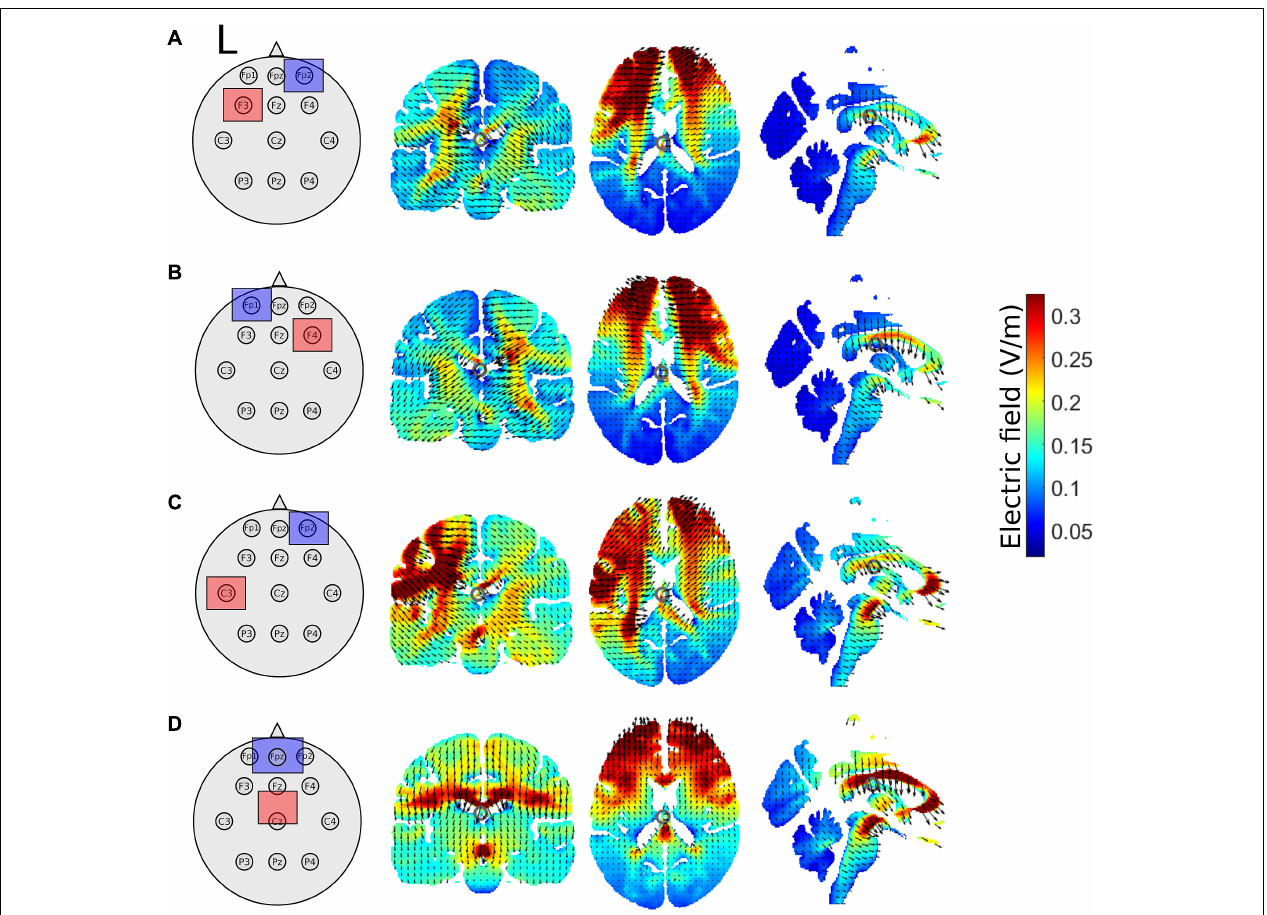
FIGURE 2 | Schematic of tDCS electrode montage and electric field magnitude distribution with current arrows in the coronal, axial, and sagittal slices for the (A) left prefrontal montage, (B) right prefrontal montage, (C) the left M1 montage, and (D) for the supplementary motor complex montage produced by the ROAST model. All images are in x = –1, y = –17, and z = 17 MNI space. The left hemisphere is denoted by L. Red squares represent the anode, whereas blue squares represent the